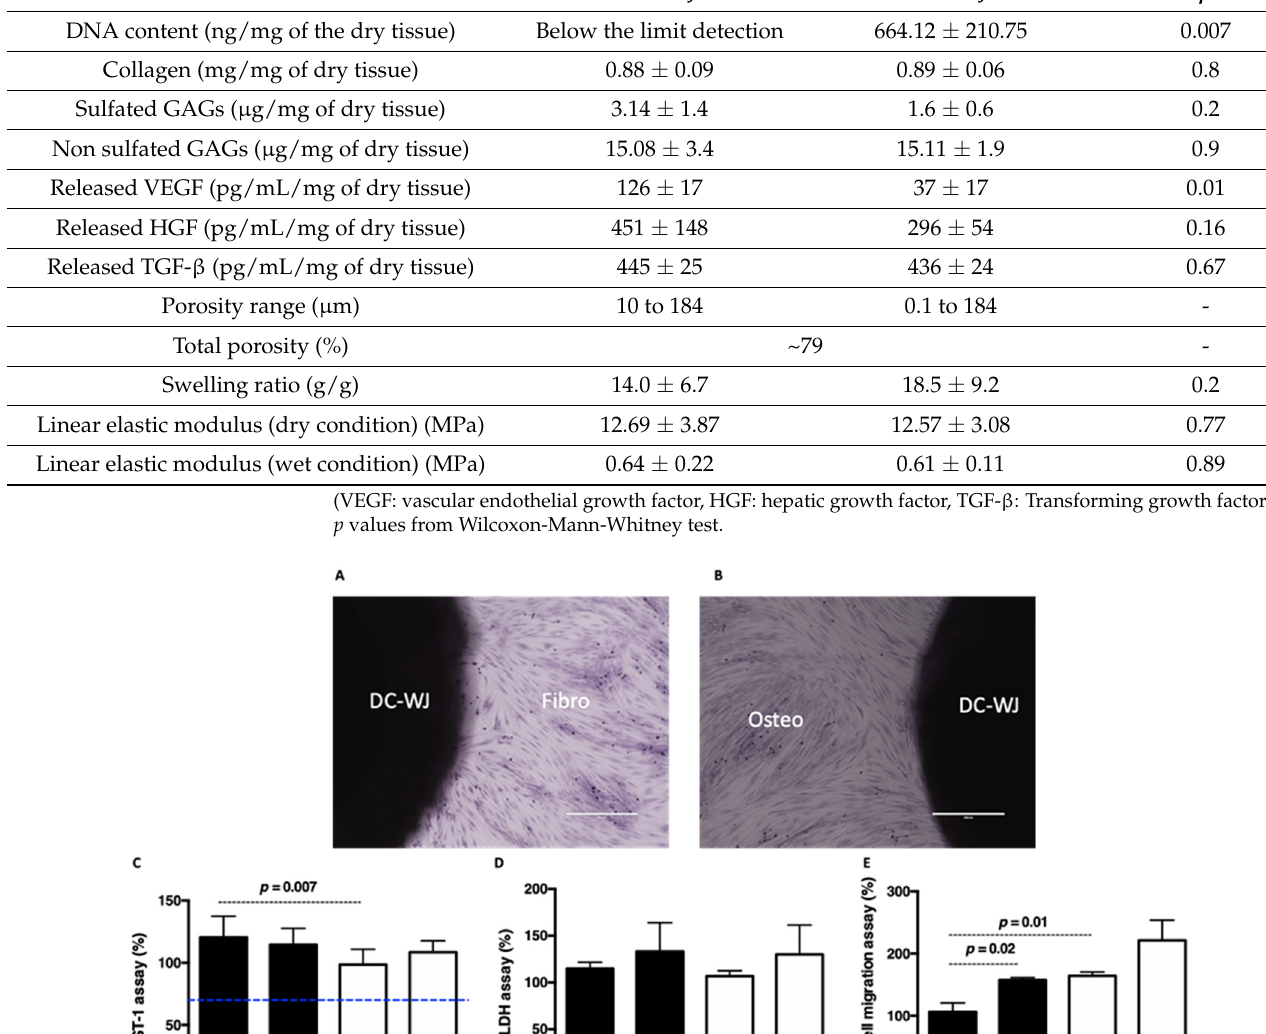
Table 1. Biochemical, physical and biomechanical characterization of decellularized and devitalized Wharton’s Jelly ( n = 5). DC-WJ DV-WJ